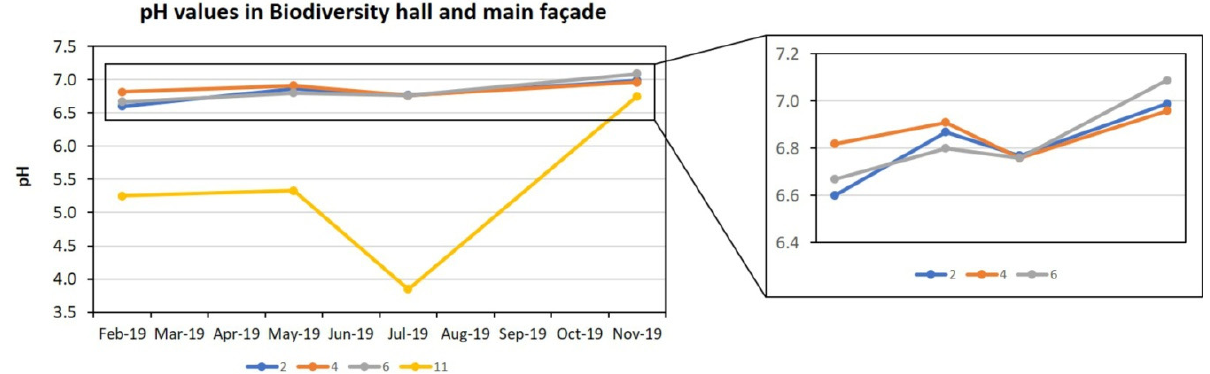
Figure 9. Evolution of pH average values recorded in the main Biodiversity hall and the main façade. Numbers at the bottom of the X axis are the sensor numbers.